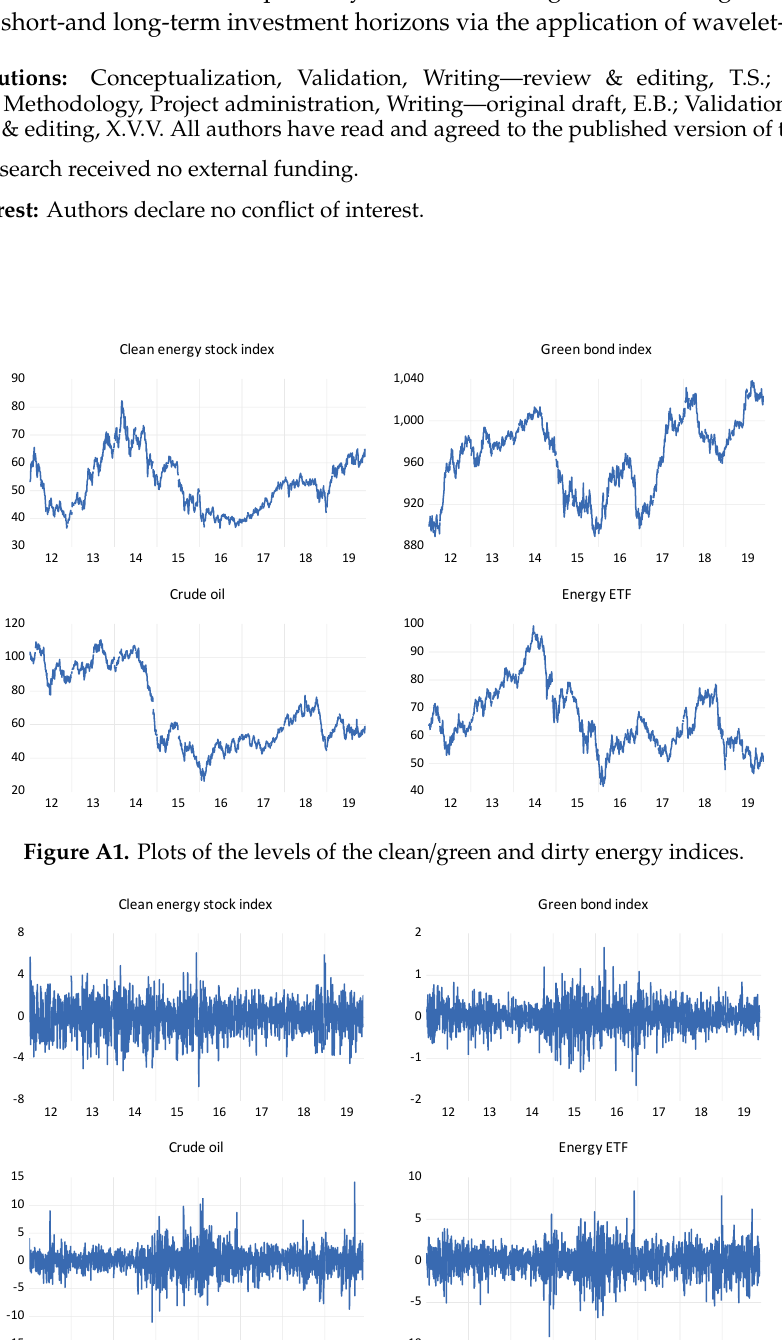
Figure A2. Plots of the returns of the clean/green and dirty energy indices.